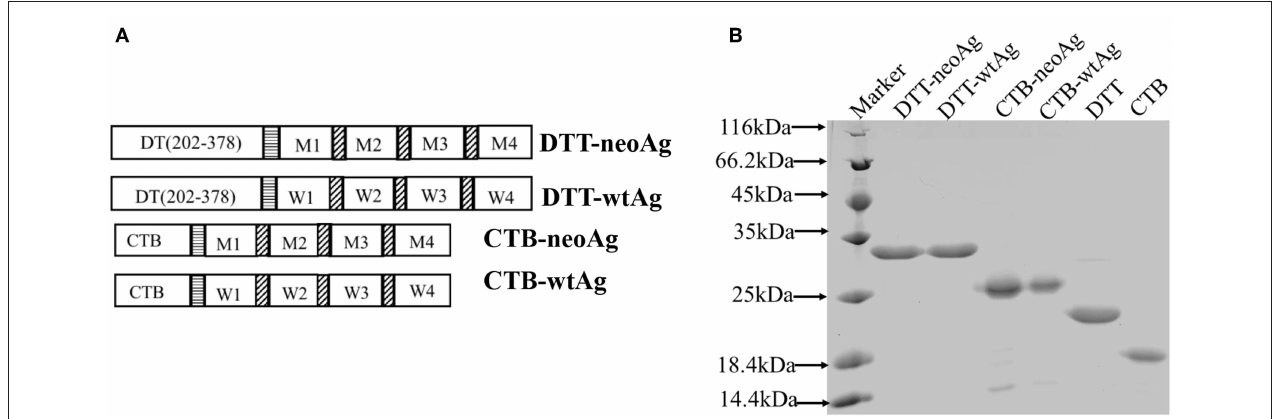
FIGURE 1 | Design and expression of DTT adjuvant-based neoantigen vaccine. (A) A schematic diagram of DTT-neoAg and DTT-wtAg. M1, M2, M3, and M4 are the mutation peptide of Pi4k2b, Ddb1, Pcdhga11 and Atp11a, respectively. W1, W2, W3, and W4 are the corresponding wild type peptides. Each mutation peptide is 27 amino acid residues in length with the mutated residue positioned in the central (position 14). The horizontal stripe box stands for the linker sequence (GGGGSGGGGS) and the diagonal stripe box stands for the linker sequence (GS). (B) 15% SDS-PAGE analysis of the purified recombinant